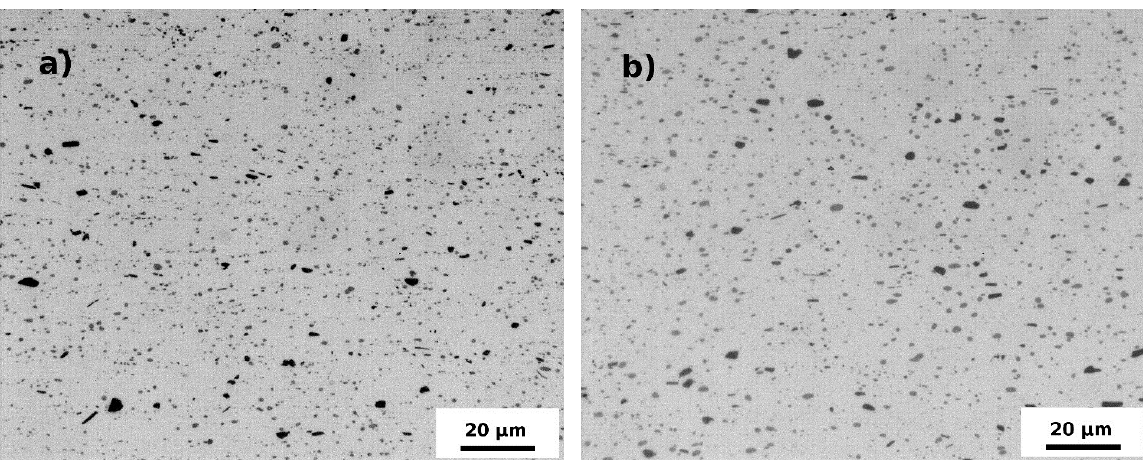
homogenization; and ( b ) in the specimen F3 annealed up to 440 °C.